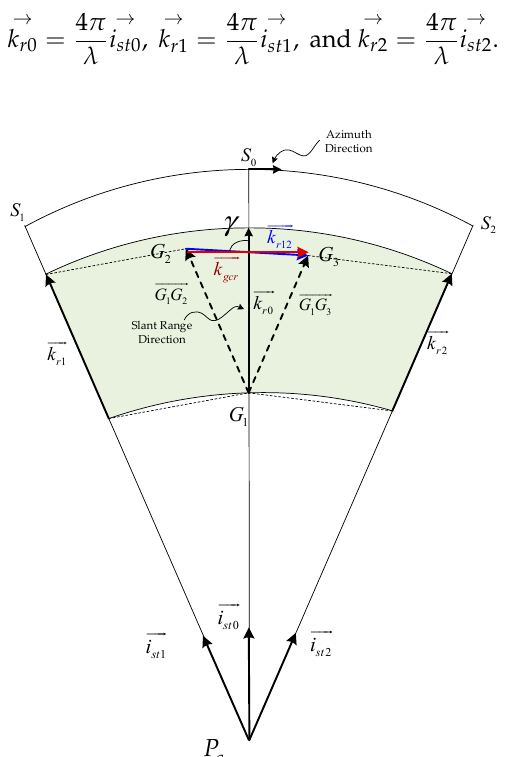
P c in the wavenumber domain. Here, S 0 , S 1 , and S 2 , are → → → i st 0 , i st 1 , and i st 2 are unit vectors from P c to S 0 , S 1 , and S 2 , different positions of the GEO SAR satellite. → → → k r 0 , k r 1 , and k r 2 are the wavenumber vectors in the corresponding directions. The respectively, and → → → → → G 1 G 2 is parallel to k r 1 , and | G 1 G 2 | = | k r 1 | . The vector G 1 G 3 is parallel to vector → → → → k r 12 = k r 2 − k r 1 and k gcr , respectively, where The blue and red arrows represent → k r 12 in the azimuth